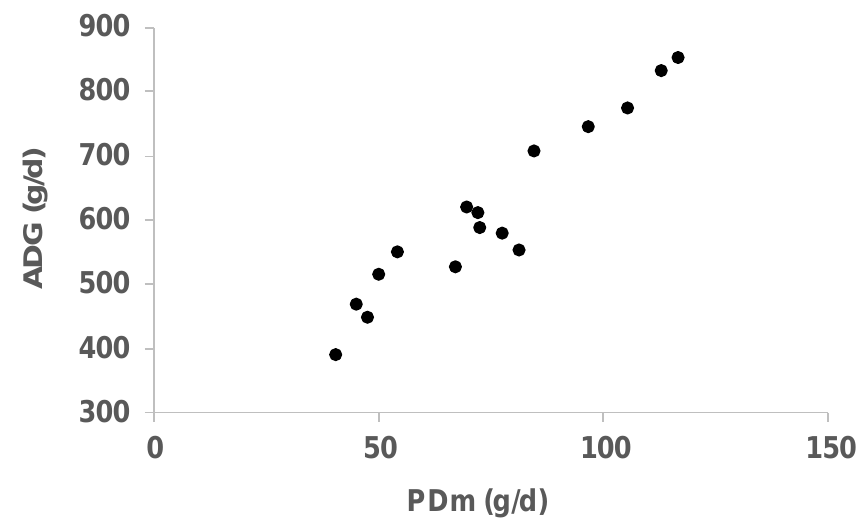
Figure 1. Relationship between mean protein deposition (PDm, g / d) and average daily gain (ADG, g / d) for nine local breeds during the period 40–100 kg BW (see correspondence between points’ values and InraPorc profiles in Table 2).